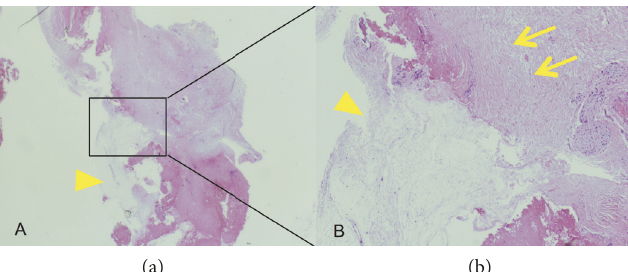
Figure 4: (a, b) Microscopic section of the cyst wall shows that the wall contained connective tissue, including collagen fibers and a few fibroblasts, and that the inner layer of connective tissue had myxoid change. The yellow arrow indicates the myxoid area, and the yellow arrowheads show connective tissue, including collagen fibers and a few fibroblasts (hematoxylin and eosin staining; A: × 12.5 magnification, B: × 50